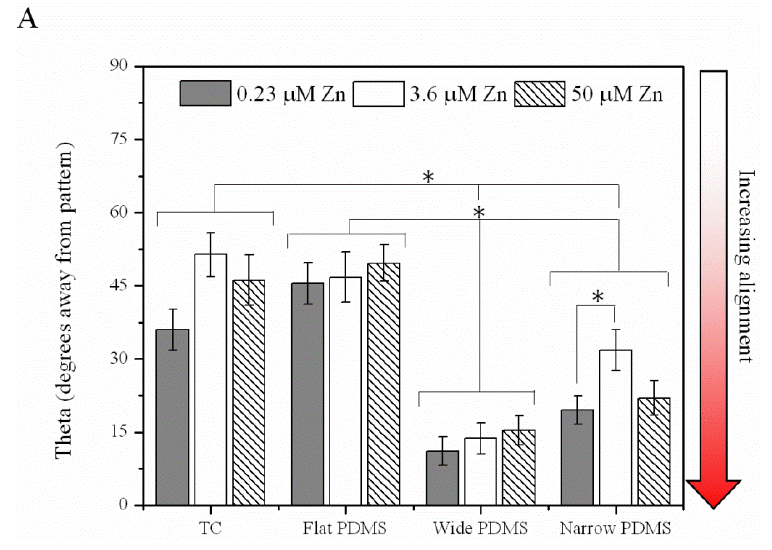
Figure 4. ( A ) Cell alignment computed from Figure 2A–D, where 0 degrees indicates complete alignment with patterned ridges/ y -axis. ( B ) Cell shape aspect ratio was calculated from the same set of images and represents the use of ImageJ’s ellipse fitting tool to determine ratio of cell width/length. A single asterisk (*) indicates a p < 0.01 level of